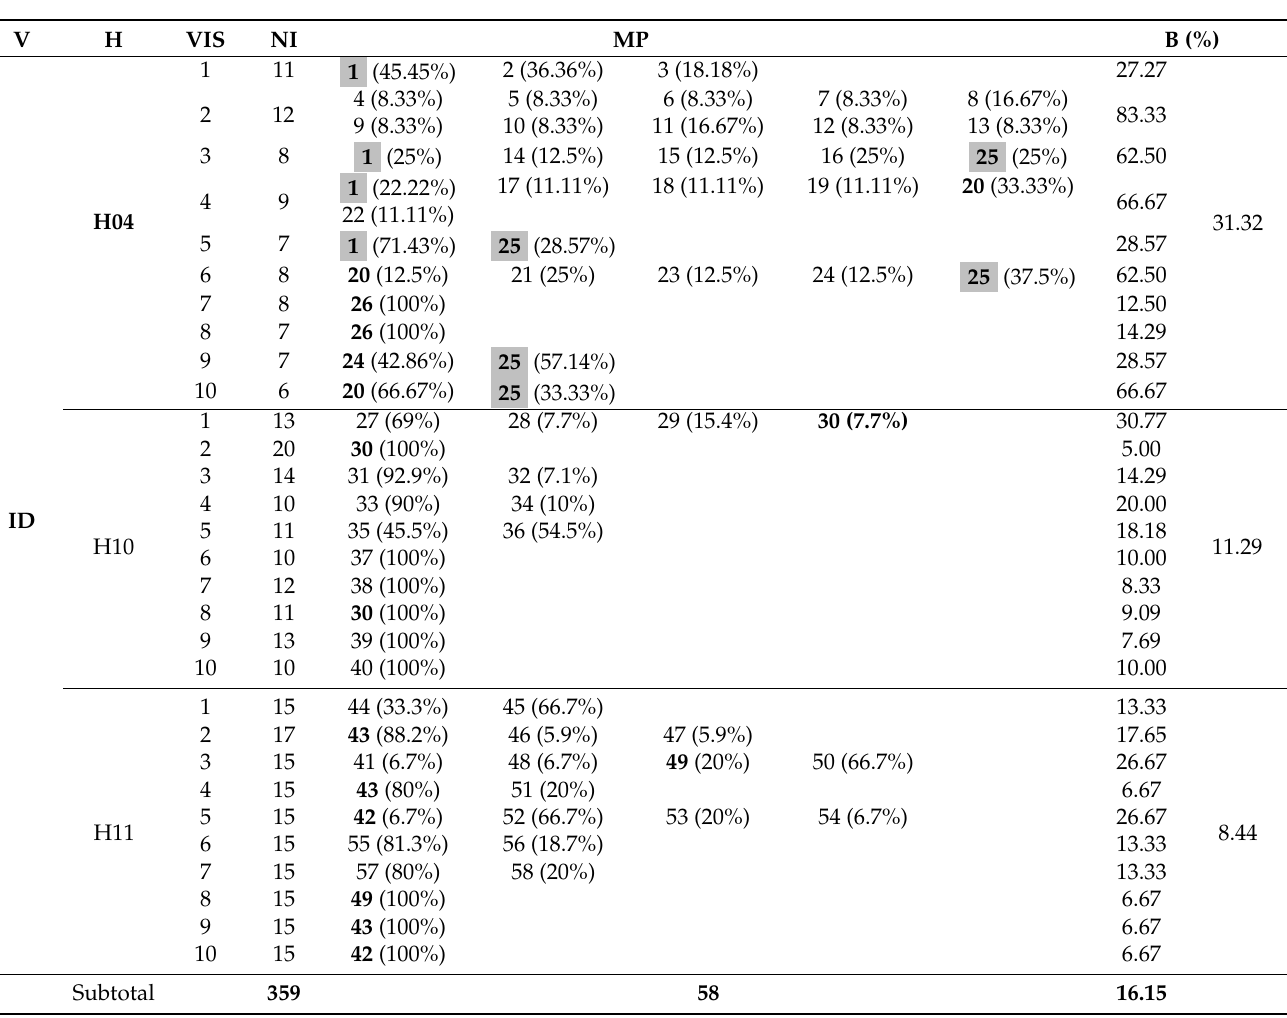
Table 1. S. cerevisiae isolates, molecular patterns, and biodiversity by sampling site according to vineyard and